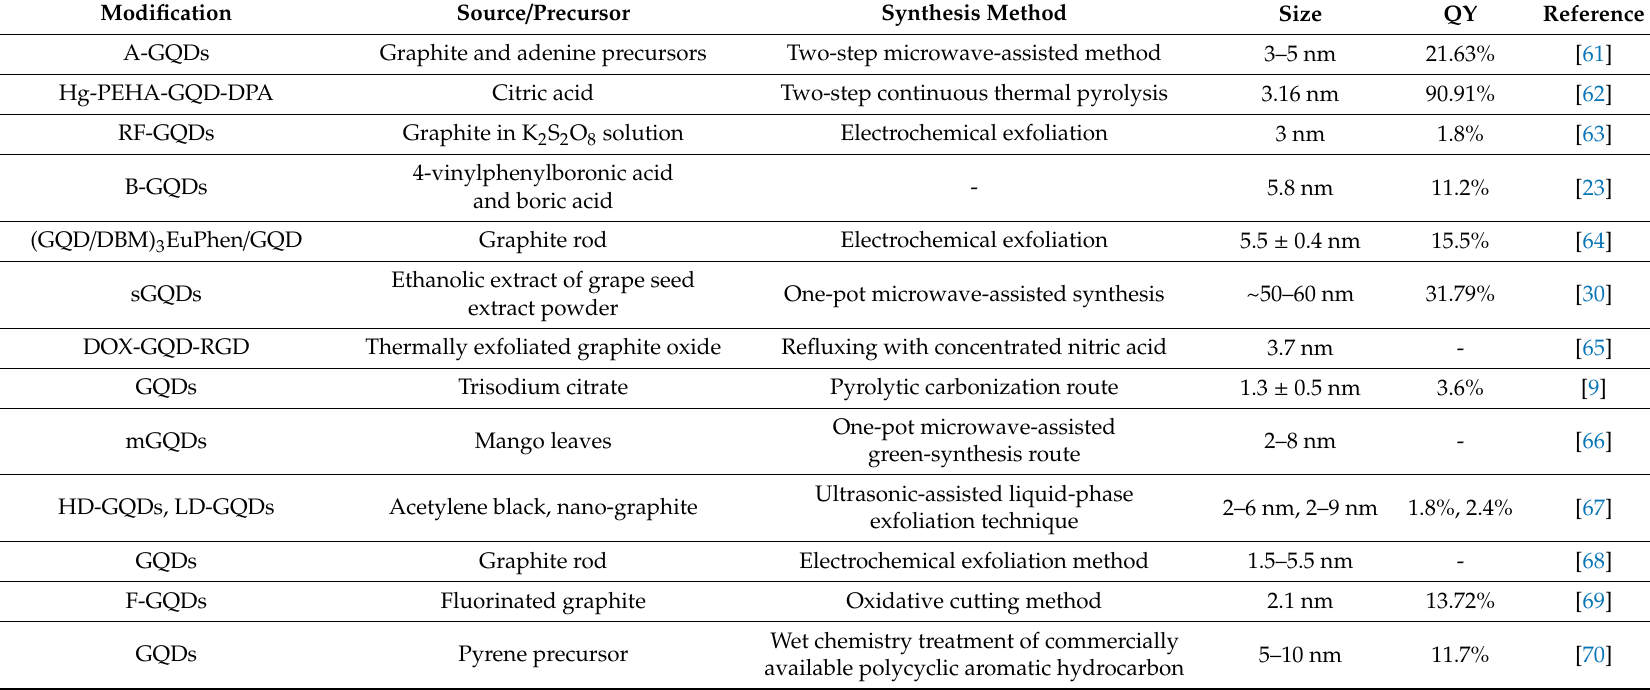
Table 1. Various approaches for synthesizing GQDs with their respective size ranges and